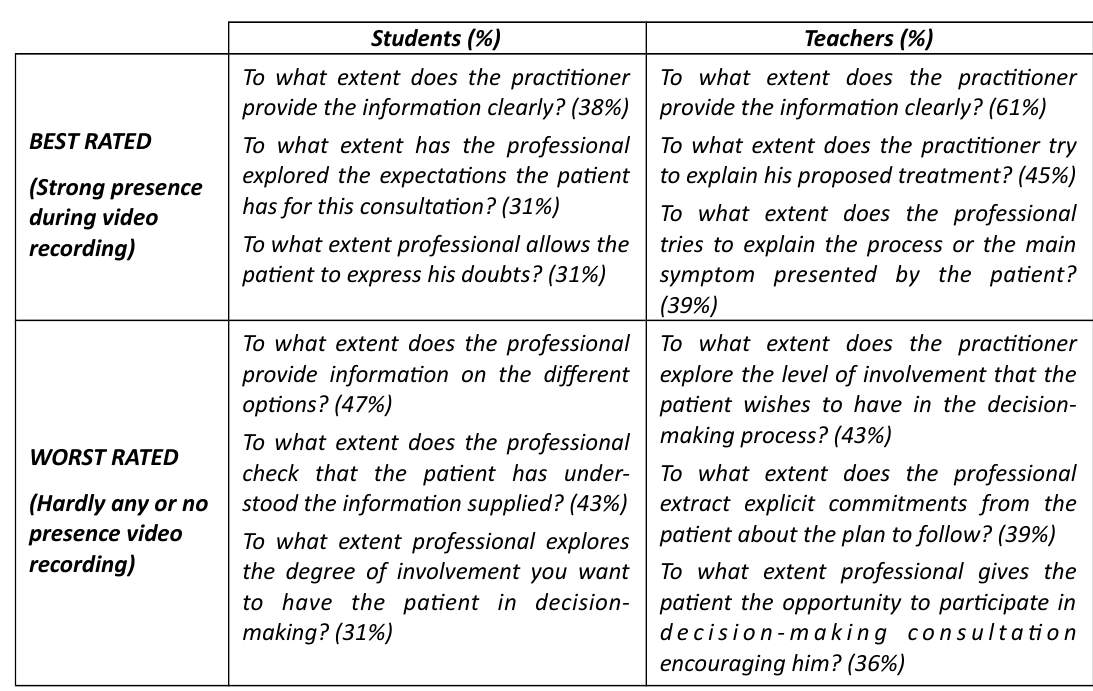
Table 4. Best and worst aspects rated by students and teachers in the use of the CICCA-D